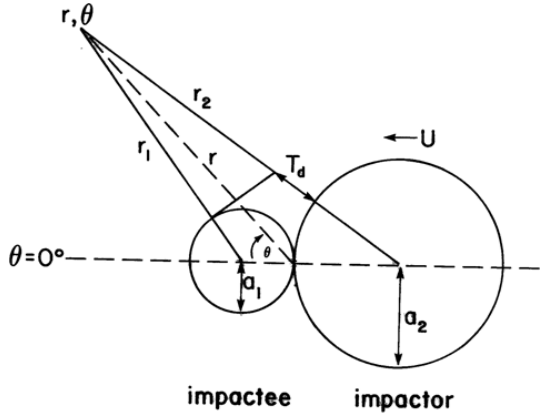
Figure 1. Geometry for the theory. The impactor of radius a 2 col- lides with velocity U and with the impactee of radius a 1 . θ is the angle between the line of sphere movement and the direction to the field point, and r is the range to the field point. T d is the difference in the arrival time of the sound radiated by the impactor relative to the